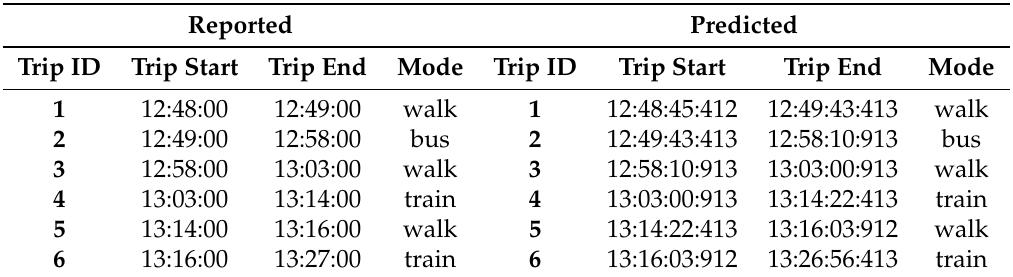
Table 11. Trip comparison between reported trips and predicted trips in an automated travel diary generated by a state-based bottom-up approach ( TrajectoryID 150615_1 ) .